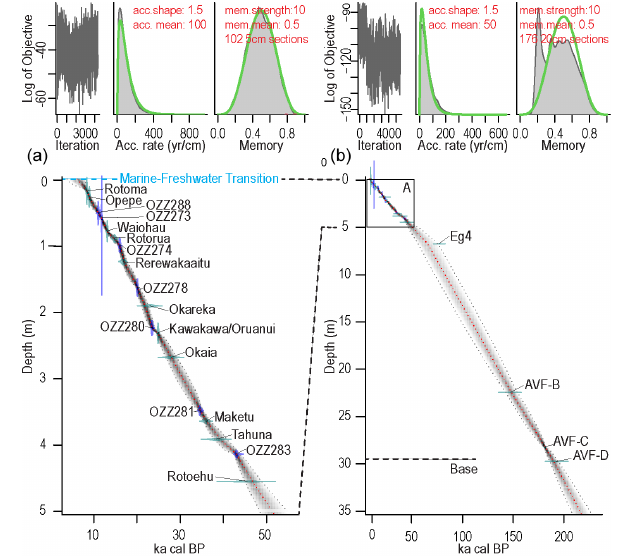
Figure 7. Onepoto lake sediment sequence age model spanning the entire sediment sequence using an event-corrected depth scale es- tablished using Rbacon (version 2.5.1; Blaauw and Christen, 2011) in R (version 1.3.1103; R Core Team, 2020). (a) Post-50ka record based on AMS 14 C ages and known-age rhyolitic tephra ages (mean 95% confidence ranges 2.03ka, min 0.31ka at 0.59m, max 6.11ka at 50m). (b) Full lake sediment sequence including andesitic tephra and basaltic ejecta as age markers in the pre-50ka part of the record (mean 95% confidence ranges 13.23ka, min 0.11ka at 0.18m, max 20.85ka at 10.81m. The accumulation rate is estimated by Rba- con by millions of Markov Chain Monte Carlo (MCMC) iterations. The memory defines how much the accumulation rate of a particular depth in a core depends on the depth above it (Blaauw and Christen,